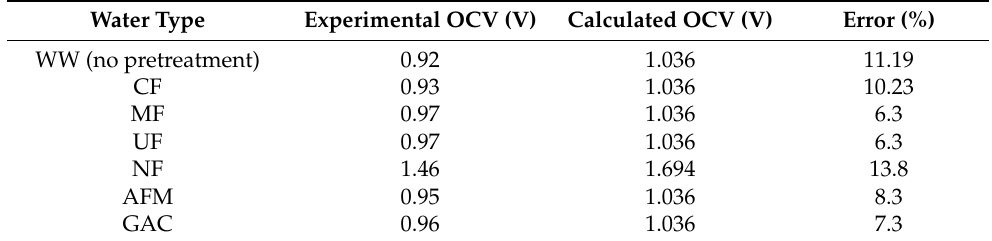
Table 6. Experimental and calculated OCVs in RED using raw feed water (WW) and pretreated water. Water